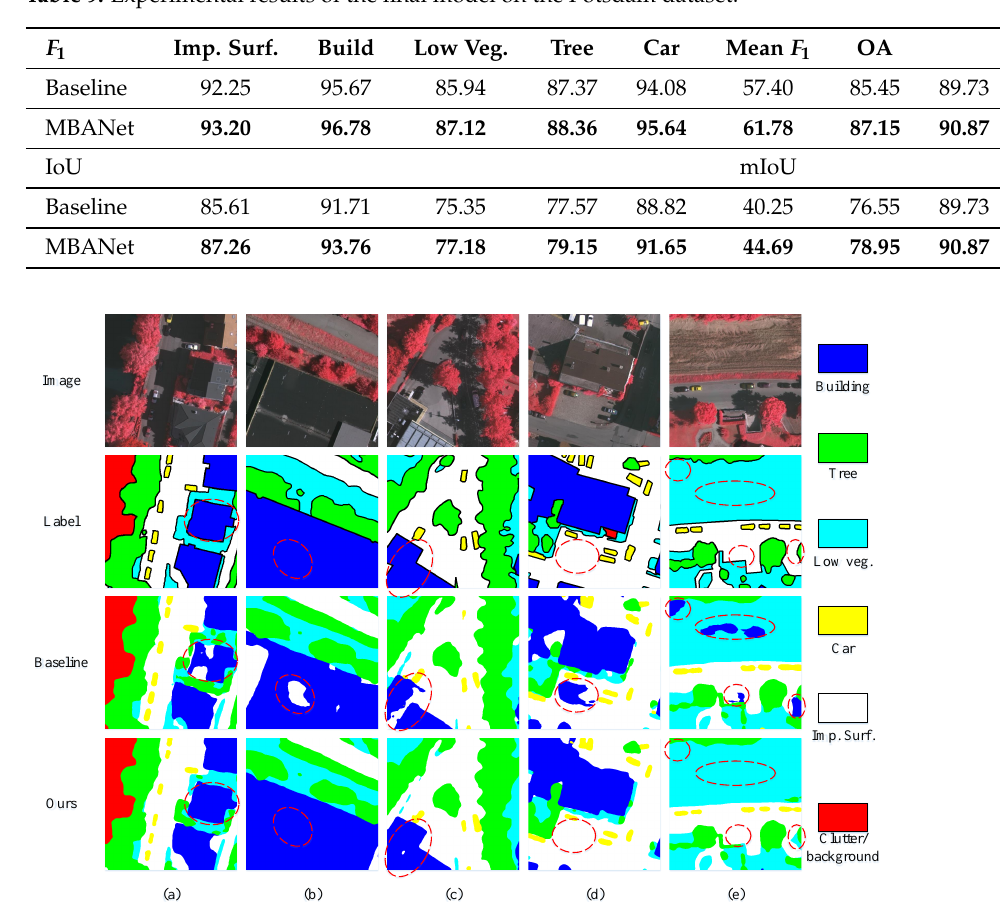
Figure 6. Visualization of the prediction results of different methods on the Vaihingen dataset. ( a – e ) correspond to five different input images, labels and segmentation results.